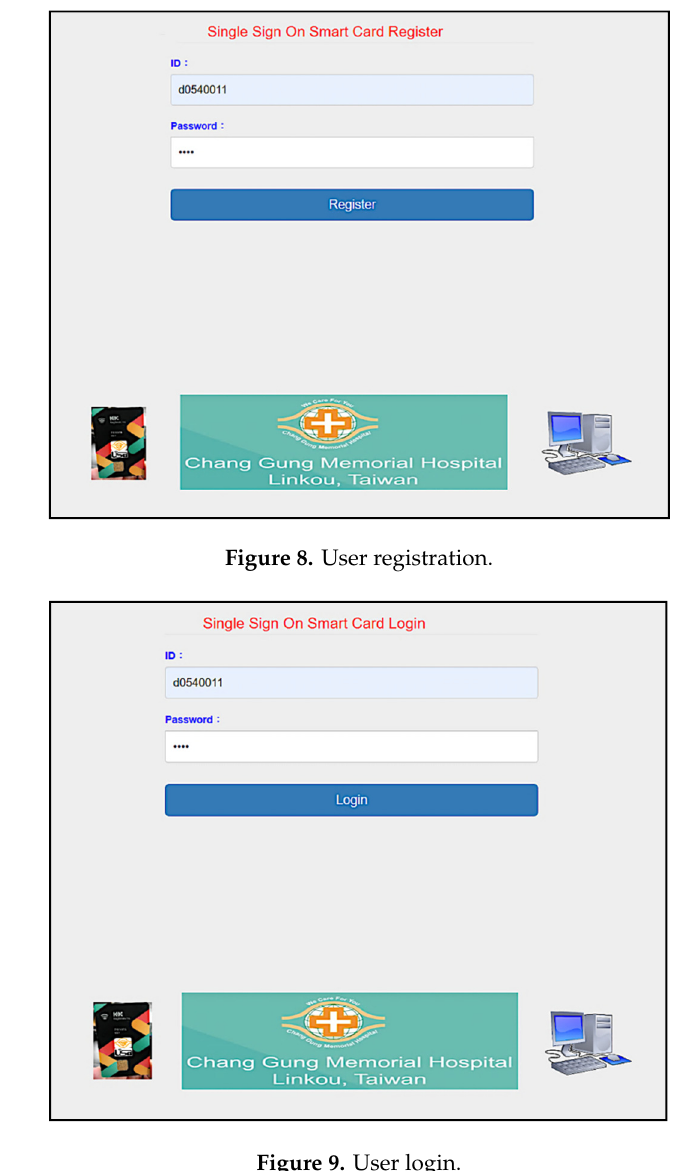
Figure 9. User login. Figure 9. User